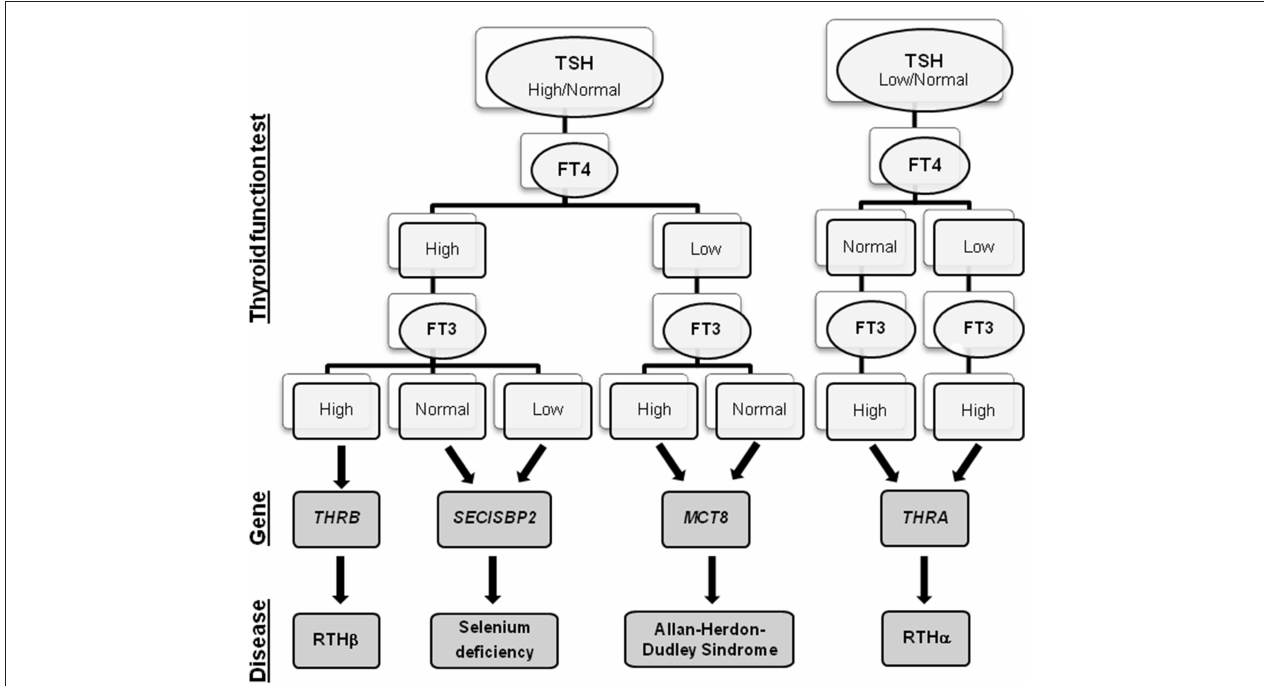
FIGURE 1 | Flowchart of THH diagnosis. For each THH disease, the associated gene and the alterations in the thyroid function tests are reported.